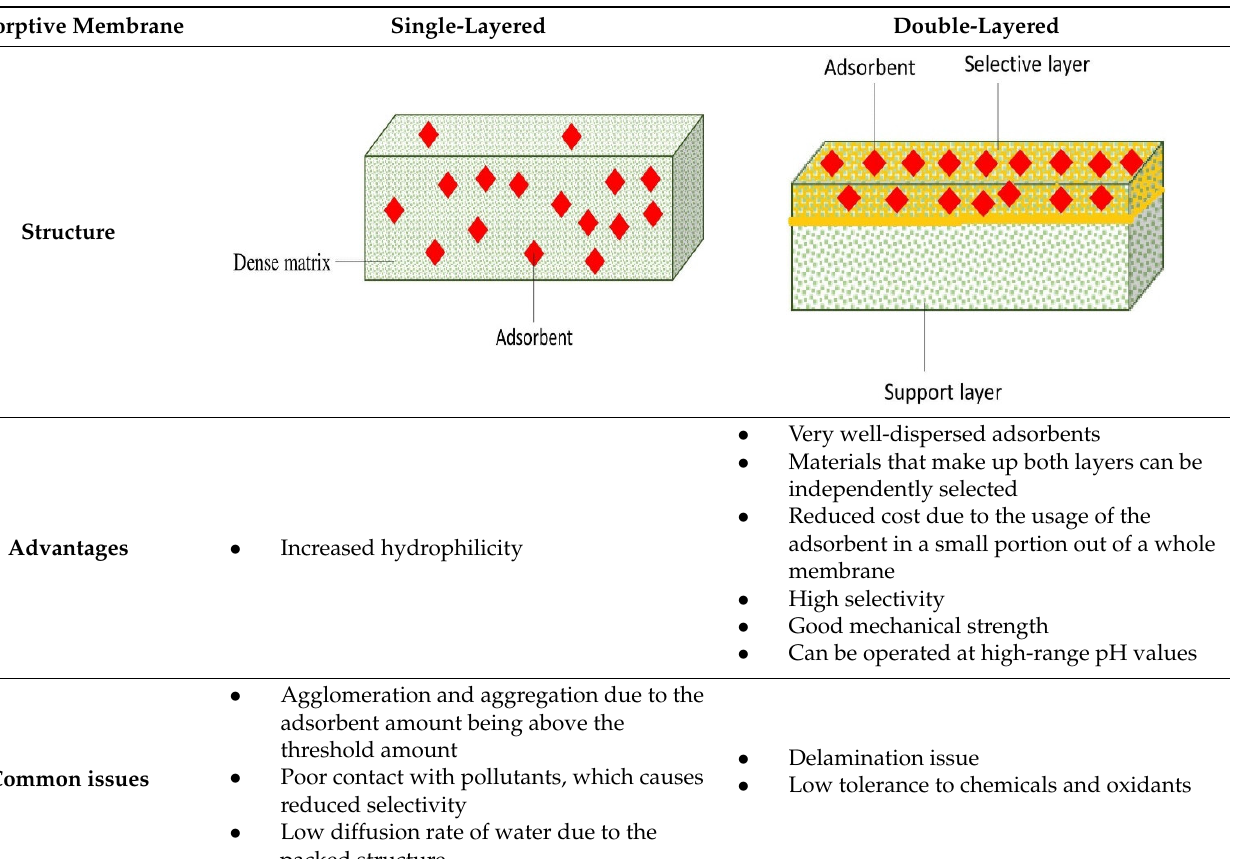
Table 5. Comparison of single-layered and double-layered adsorptive membranes.